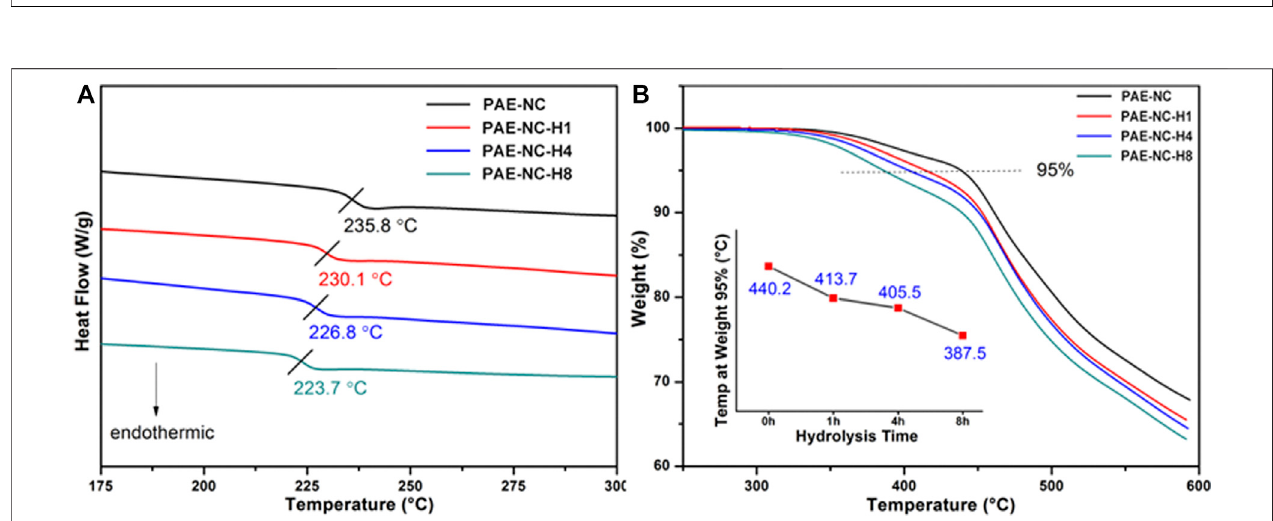
FIGURE 2 | The DSC thermograms (A) and TGA curves (B) PAE-NC are subject to alkaline hydrolysis at different times.